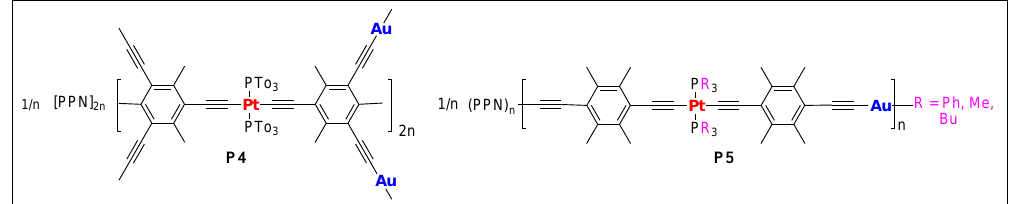
Figure 4. Pt(II)/Au(I) heterometallic anionic poly(metalla-ynes) P4 and P5 . (PPN = bis(triphenylphosphine)iminium cation). Table 1. Photoluminescence (PL) data of some selected heterometallic poly(metalla-ynes) P1–P3 and P6–P11 .